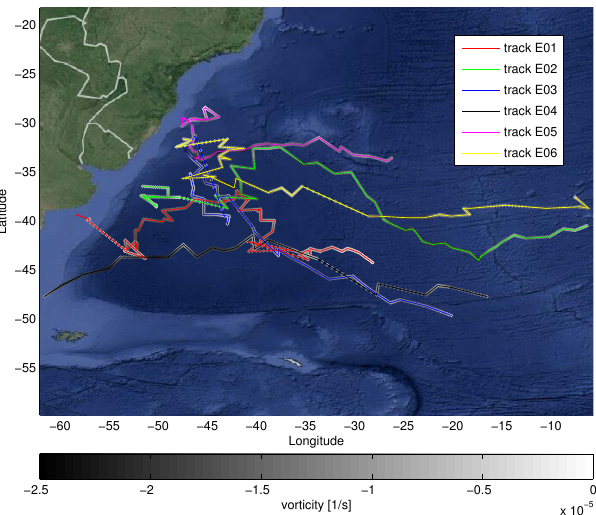
Figure 4. From the colored lines, it is possible to identify each anti-